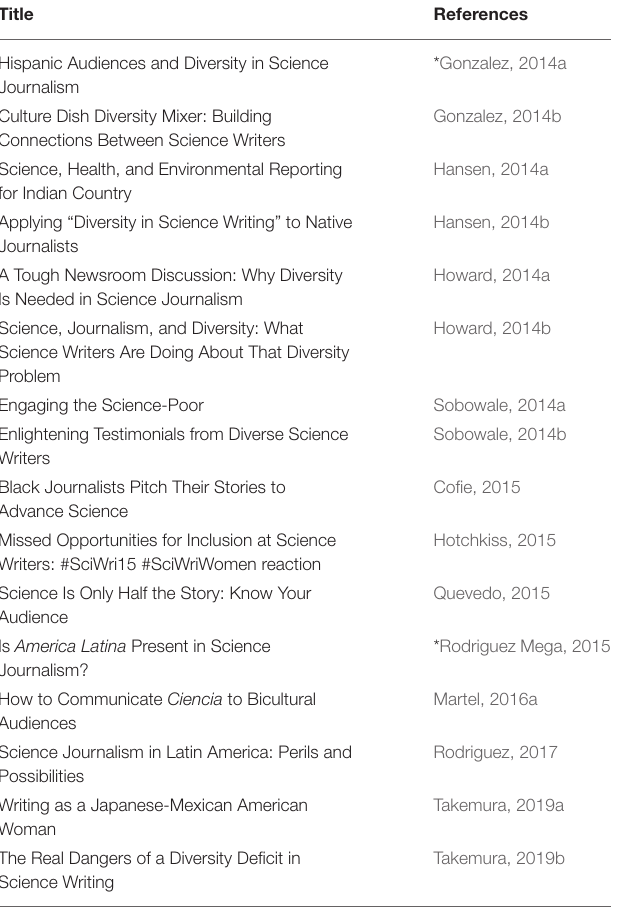
TABLE 2 | Fellow’s reporting assignments documenting diversity issues and published as DiverseScholar magazine articles.